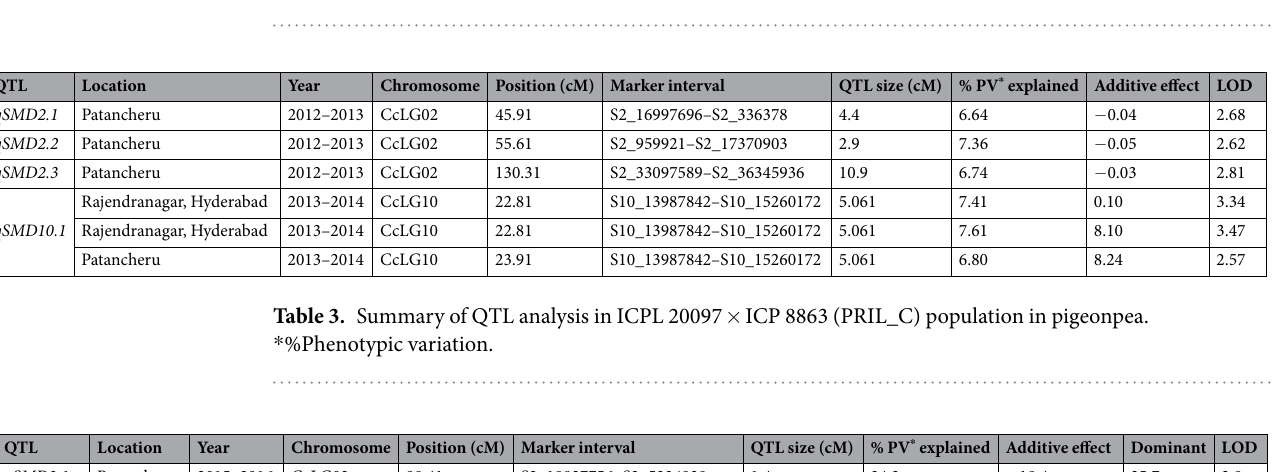
Table 2. Results of QTL analysis in ICPL 20096 × ICPL 332 (PRIL_B) population in pigeonpea. * %Phenotypic variation.